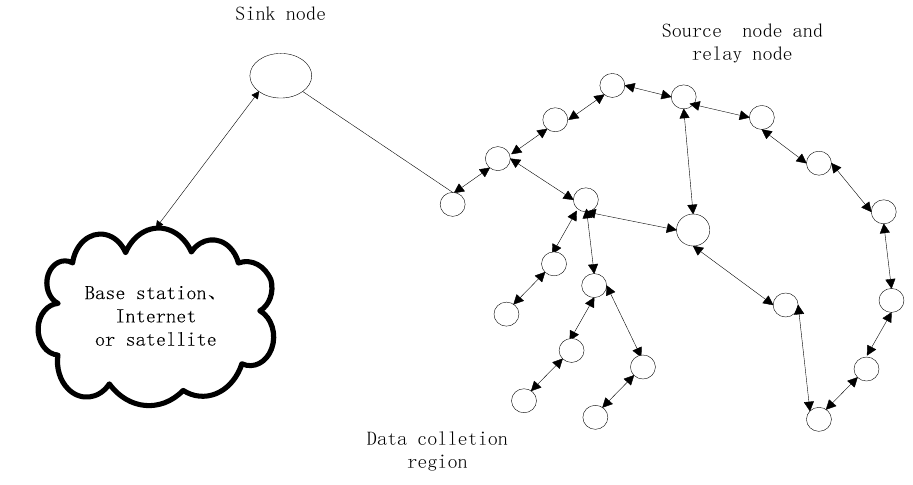
Figure 4. No cluster head architecture of WSN.